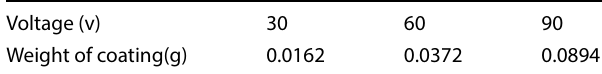
Table 2 Weight of coatings at different